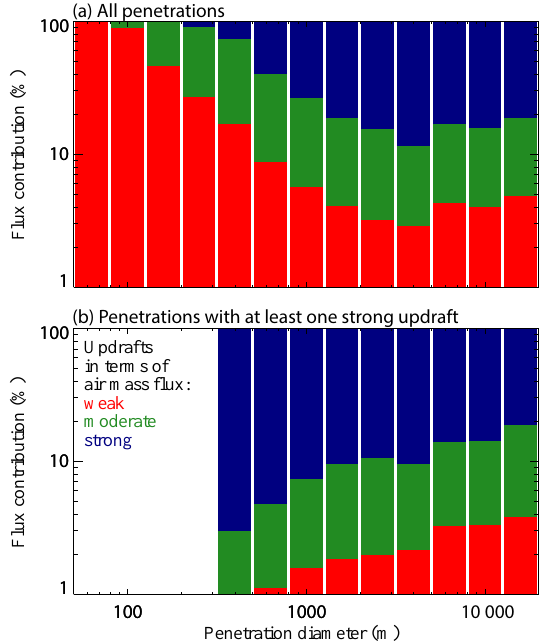
Figure 7. Average percentile contribution to total upward air mass flux by the weak (red), moderate (green), and strong (blue) updrafts delineated in this study. The result is a composite of HiCu, COPE, and